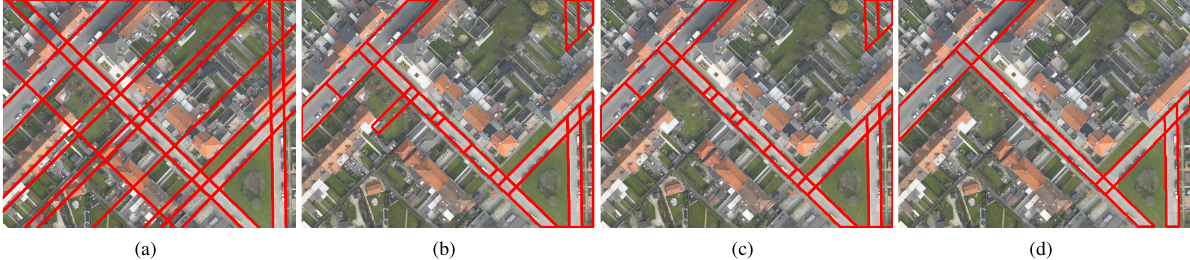
Figure 2: Segmentation of the image using the Hough lines. (a) All the segments, (b) Segments after discarding the irrelevant ones based on their homogeneity. (c) The remaining segments after removing the ones with a high average height value, (d) The road segments after merging and discarding ones which are not connected.